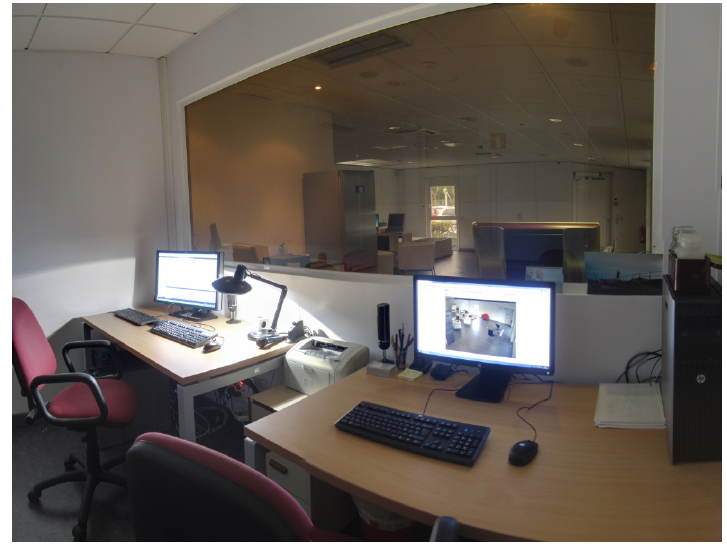
Figure 3. The overall view of the observation area of the Smart House Living